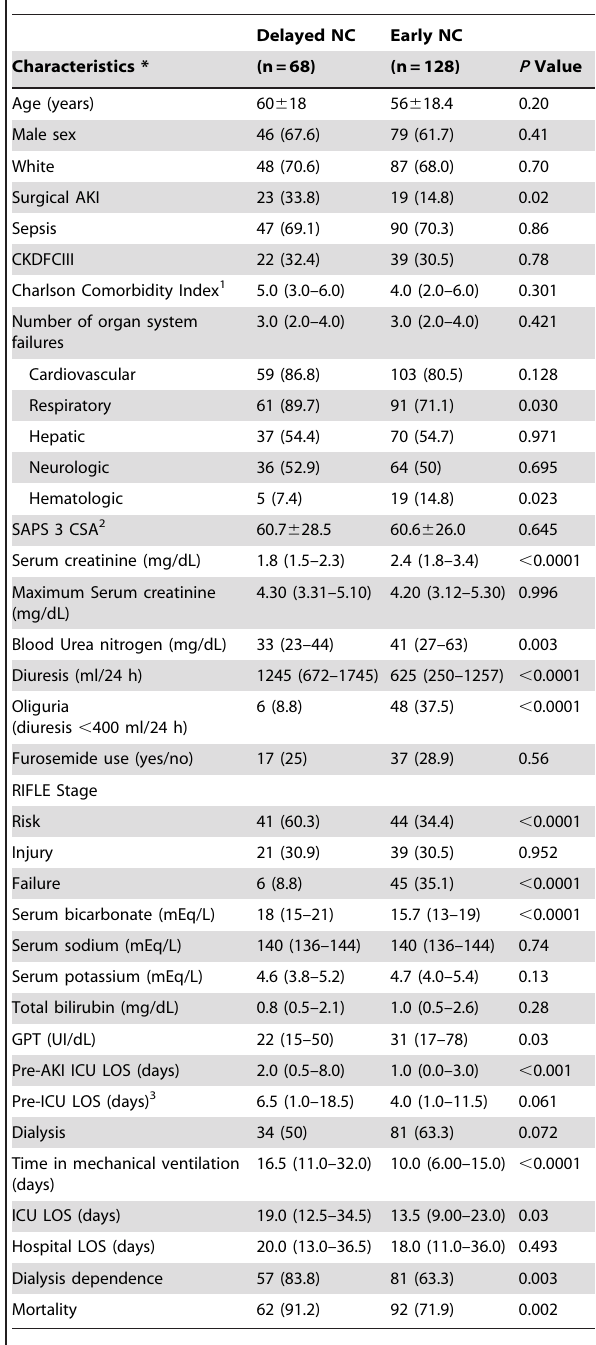
Mortality 62 (91.2) 92 (71.9) 0.002 *Results are expressed in number (%), mean 6 SD or median (25–75 IQR). 1 Age points were suppressed. 2 Mortality probability. 3 After hospital admission; SD, standard deviation; IQR, interquartile range; CKDFCIII, chronic kidney disease functional class III; ICU, intensive care unit; CRRT, continuous renal replacement therapy; AKI, acute kidney injury; LOS, length of stay; SAPS, simplified acute physiology score; CSA, customized equation for countries from Central and South America; GPT, alanine aminotransferase.